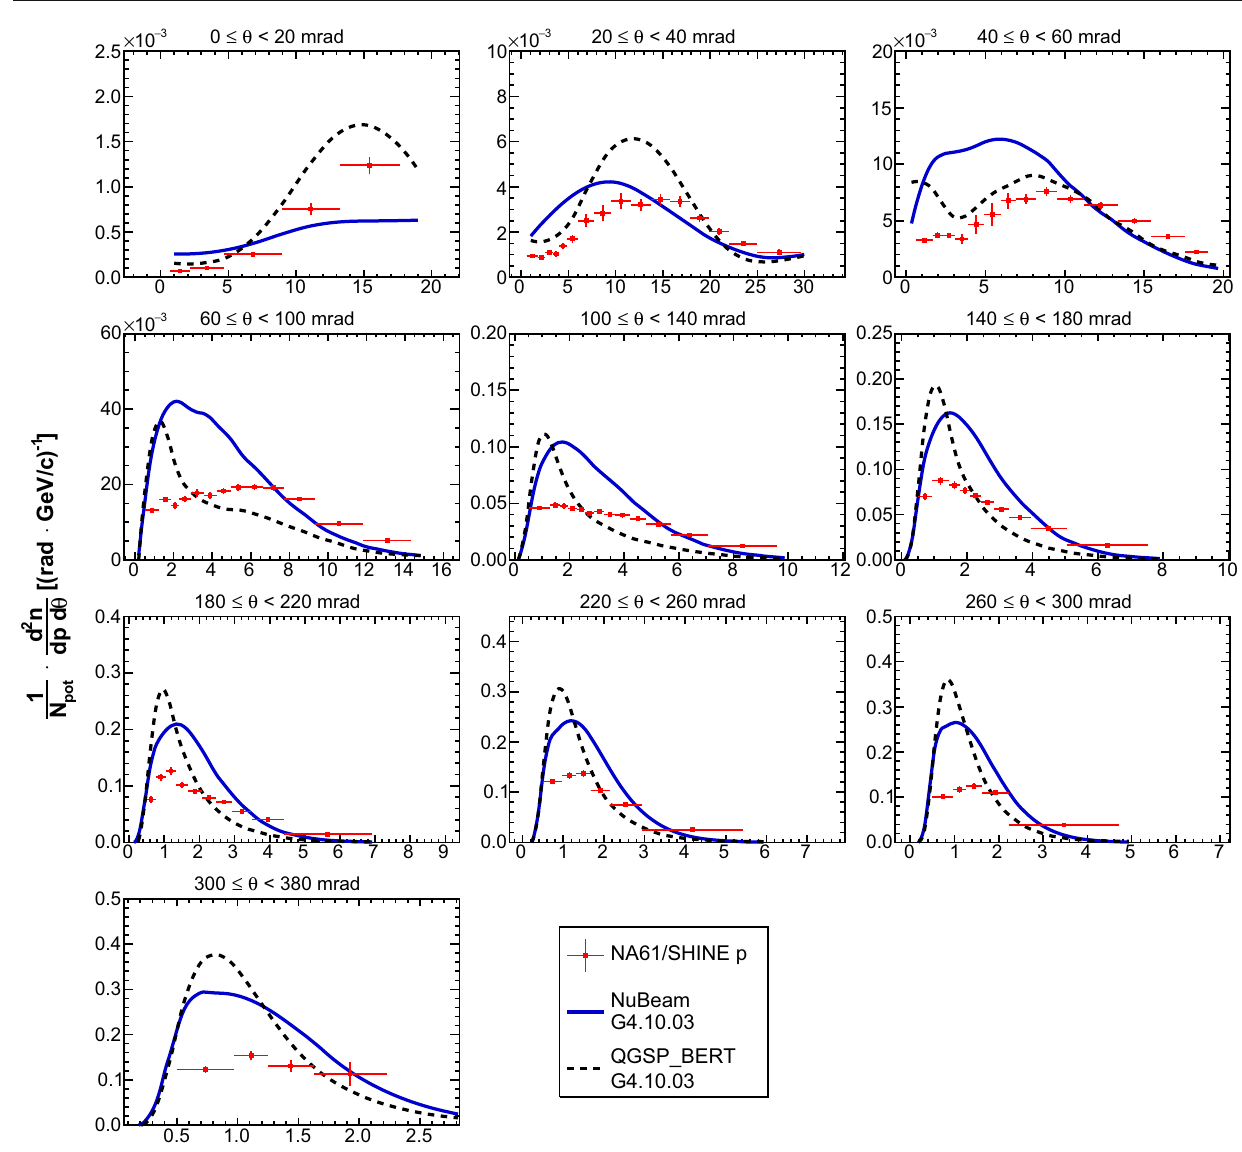
QGSP_BERT (dashed black line) physics lists from Geant4.10 .03 [27,28] are overlaid on top of the data